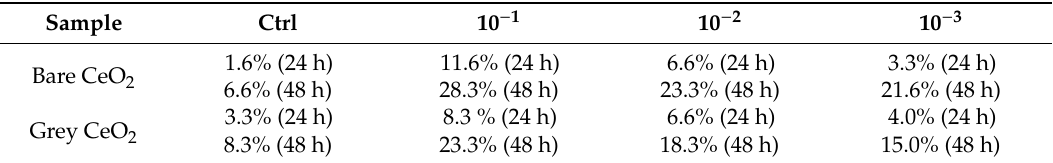
Table 1. Percentages of immobilized nauplii after exposition to CeO 2 (bare CeO 2 and grey CeO 2 ) at three di ff erent concentrations for 24 and 48